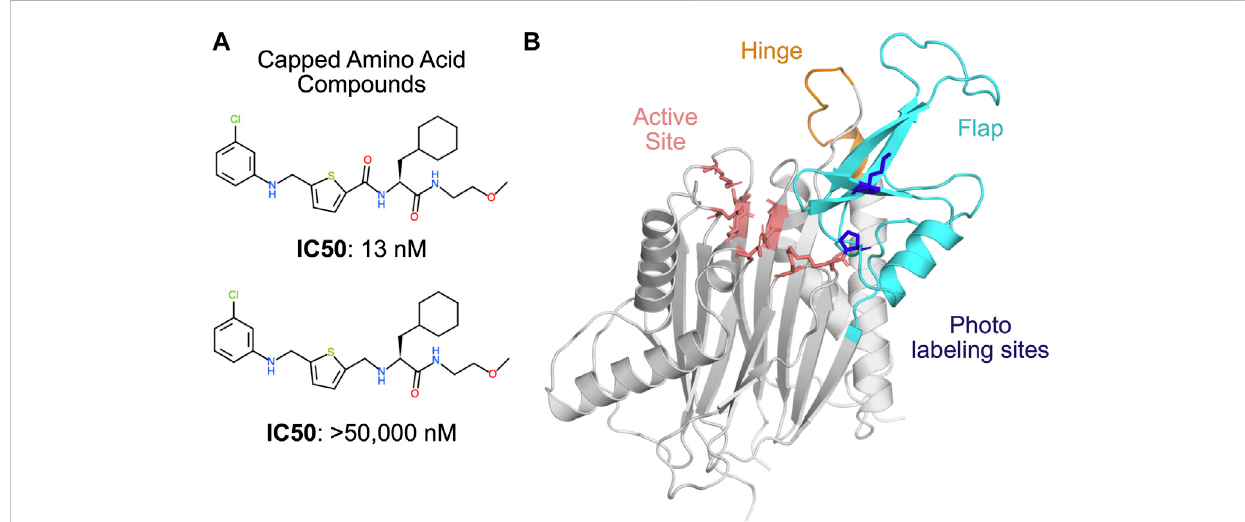
FIGURE 1 PPM1D phosphatase is allosterically inhibited by the capped amino acid (CAA) compounds, but the precise binding site is unknown. (A) The capped amino acid compounds have a common amino acid-like substructure, and small differences in their chemical structure (i.e., the absence of a carbonyl) can contribute to very large differences in their potency. (B) The AlphaFold-predicted structure of PPM1D highlights key regions that have been implicatedinthebindingofthecappedaminoacidcompounds.Theactivesiteisshowninsalmonstickswhiletworesiduesidenti fi edasproximalto the binding site based on photolabeling experiments are shown in blue sticks. The fl ap domain, a region hypothesized to be the primary CAA compound binding site, is shown in cyan. Another region hypothesized to be the primary CAA compound binding site, the hinge, is shown in